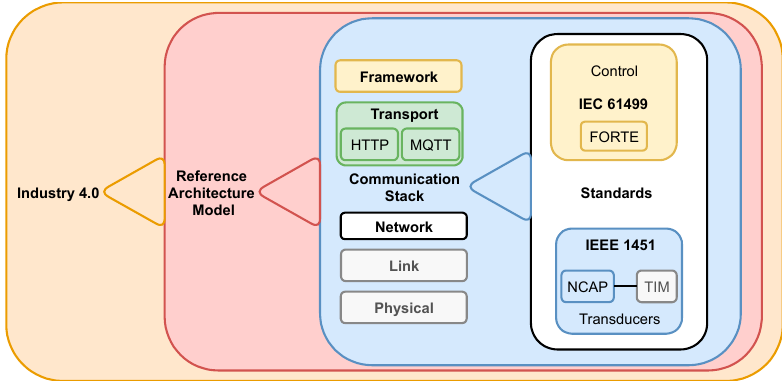
Figure 2. Encapsulation of an Industry 4.0 communication layer.